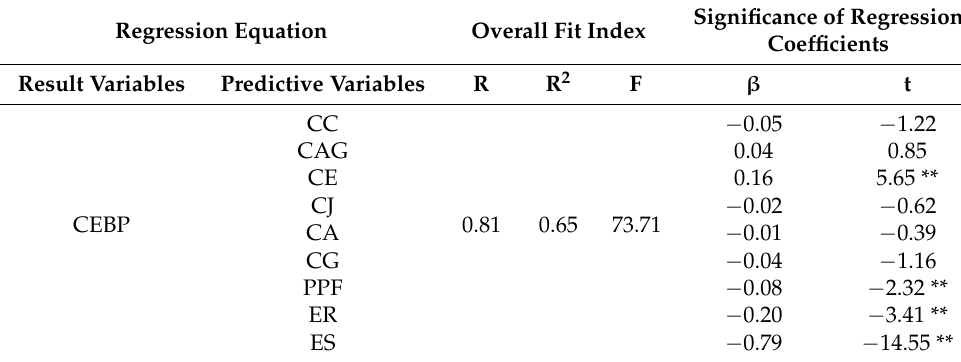
Table 2. Regression analysis of externalizing behavior problems. Regression Equation